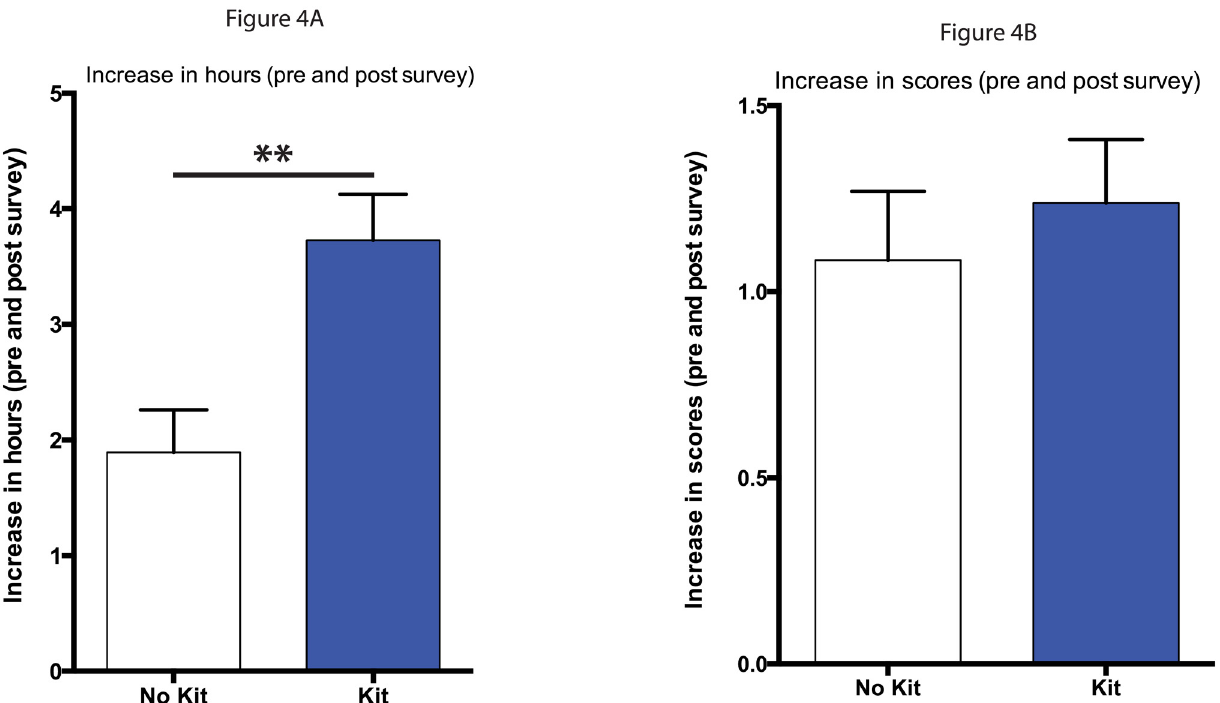
Fig 4. Change in hours spent using personal genomics products and scores on personal genomics quiz. A) Students reported hours spent using personal genomics products on pre and post surveys. The change in hours (increase) between the pre and post surveys were calculated and the data from students who did not receive kits (white) were compared with the data from students who did (blue). B) Student took a 10-question personal genomics quiz on pre- and post-surveys. The change in scores (increase) between the pre and post surveys were calculated and the data from students who did not receive kits (white) were compared with the data from students who did (blue). Statistical analysis for A and B were performed using an unpaired Student t-test and all values are mean ± SEM with n = 71 for no kit, and n = 84 for kit ( ** = p < .01).